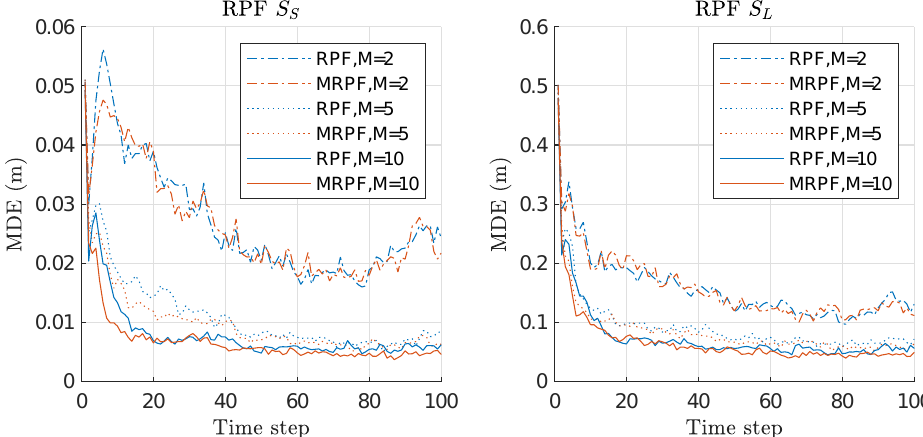
Figure 7. Mean distance error (MDE) performance comparison between regularized PF (RPF) and minimax RPF (MRPF). Three hundred runs were performed with 1000 particles, where M , S S , and S L denote the number of sensors, the scenario of the small state noise variance, and the scenario of the large state noise variance,